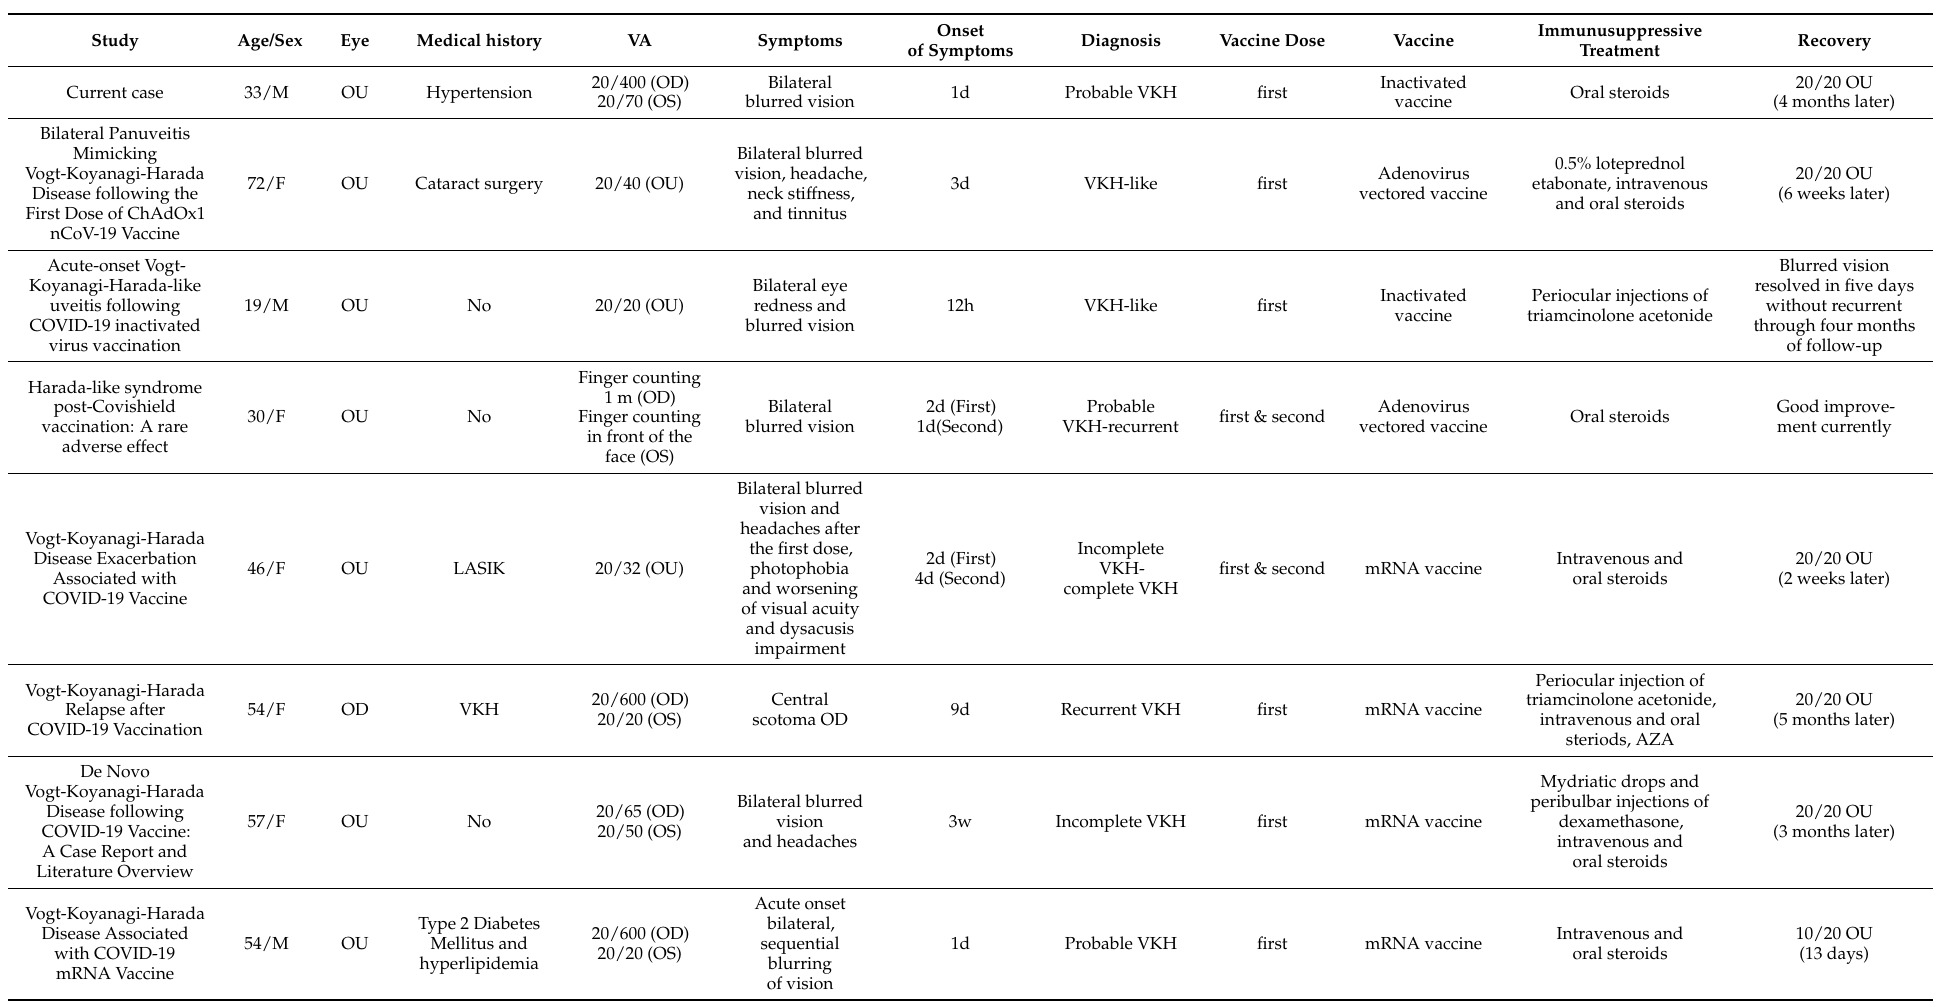
Table 2. Clinical characteristics of our case in comparison with the other previously reported patients with Vogt–Koyanagi–Harada (VKH) or VKH-like symptoms in temporal association with the COVID-19 vaccination